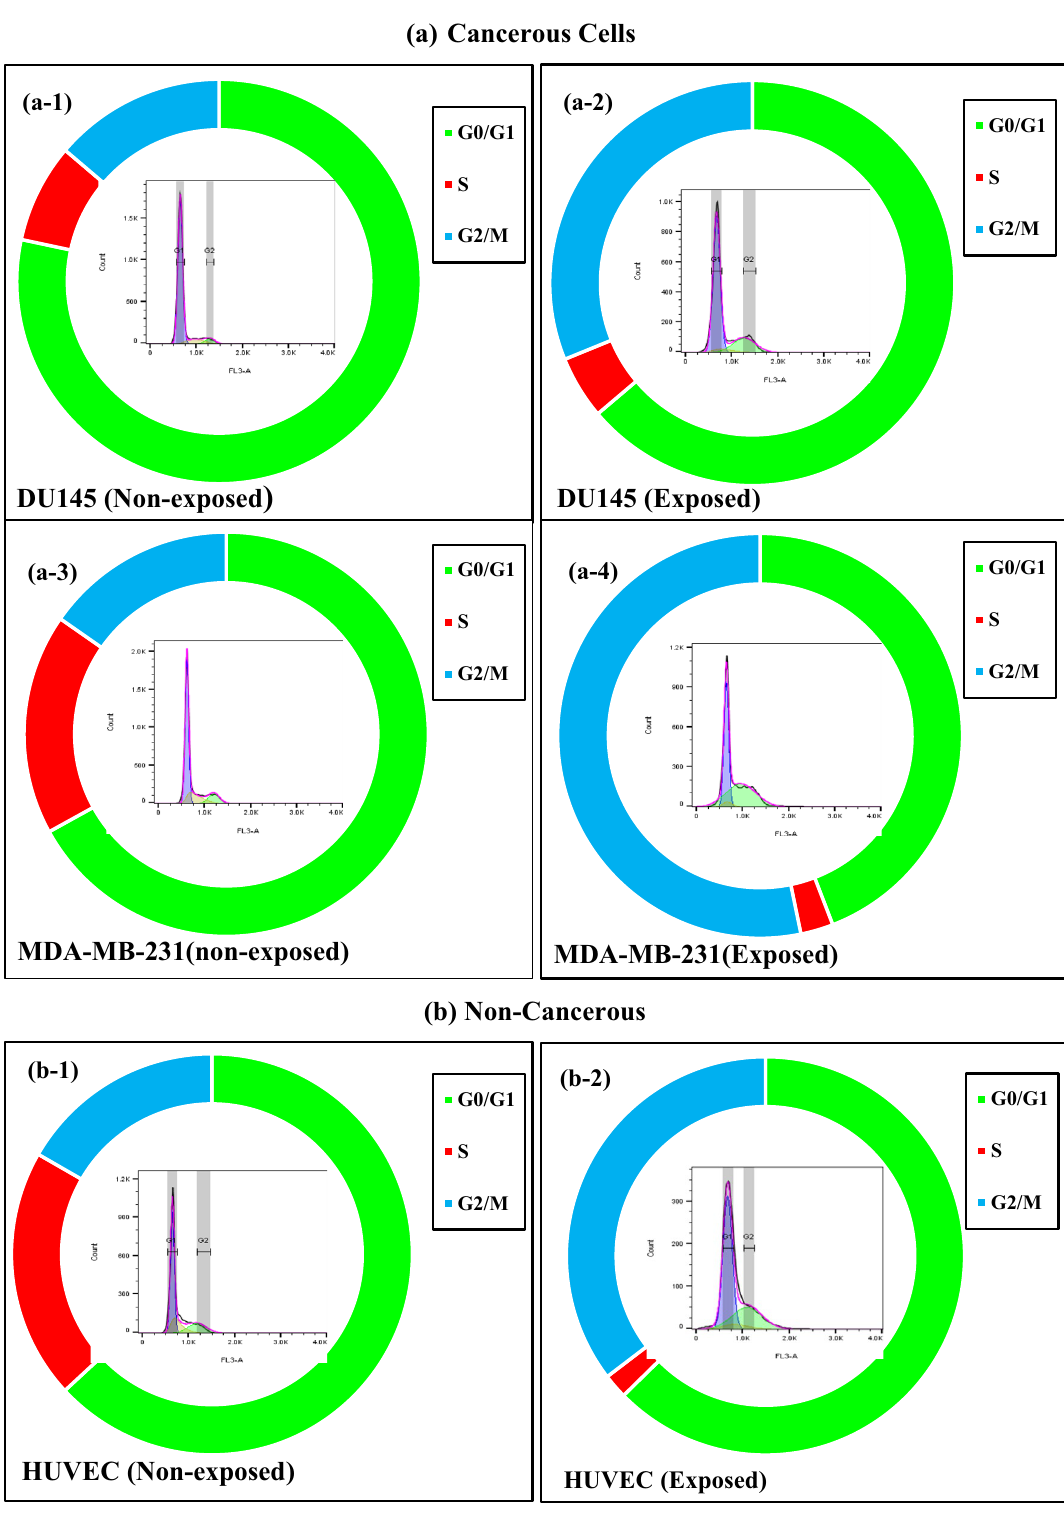
Figure 9. ELF-EMF induced cell cycle arrest. We used Flow cytometry to determine the effect of ELF-EMF on the cell cycle distribution of DU145, K562 and HUVEC cell lines (0.01 Hz, 100 mT, 120 h), MDA-MB-231 cell line (1 Hz, 100 mT, 120 h). Histograms showing the cell cycle distribution of the non-exposed and exposed ( a ) cancerous cells: (a-1) DU145 (Non-exposed, (a-2) DU145 (Exposed), (a-3) MDA-MB-231(non-exposed), (a-4) MDA-MB-231 (Exposed), ( b ) non-cancerous cells: (b-1) HUVEC (Non-exposed), (b-2) HUVEC(Exposed), ( c ) suspended cells: (c-1) K562(Non-exposed), (c-2) K562(Exposed) under ELF-EMF exposure. The histogram in the center shows flow cytometric images of the cell cycle for each cell